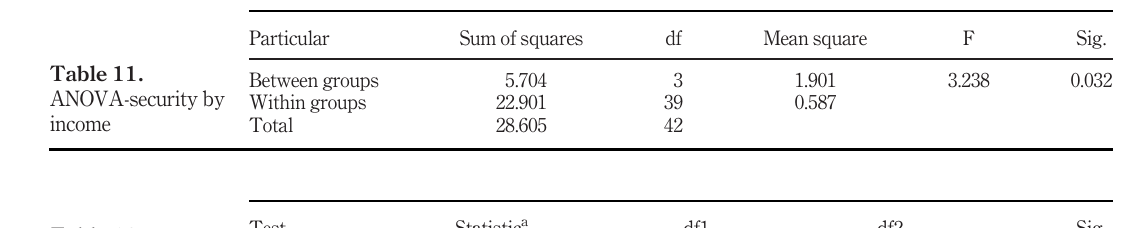
Table 12. ANOVA-(robust tests) security by income